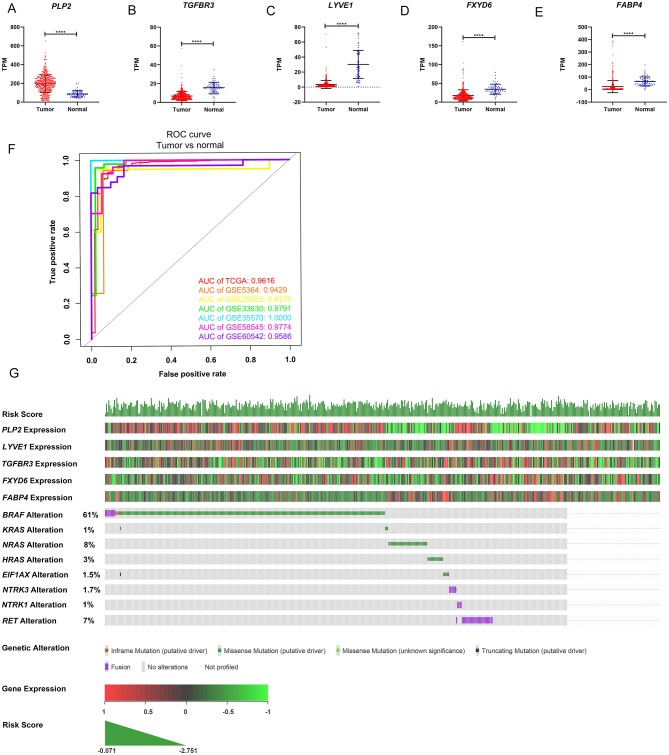
Expression level of the five genes in papillary thyroid carcinoma (PTC) and the mutation landscape of PTC. (A–E) Show the mRNA expression levels of the five genes in the PTC tumor tissues and normal tissues of the TCGA-THCA dataset. (F) Receiver operating characteristic (ROC) curve showing the performance of the five-gene signature in differentiating normal thyroid tissue from PTC tissue in the GEO and TCGA datasets. (G) The relationship among the 5-gene signature, transcriptome profiles and mutational profiles (BRAF, RAS, EIF1AX, NTRK3-fusion, NTRK1-fusion, RET-fusion and BRAF-fusion) of PTC. Data were obtained from the cBioPortal for Cancer Genomics (https://www.cbioportal.org). *p < 0.05, **p < 0.01, ***p < 0.001, ****p < 0.0001.